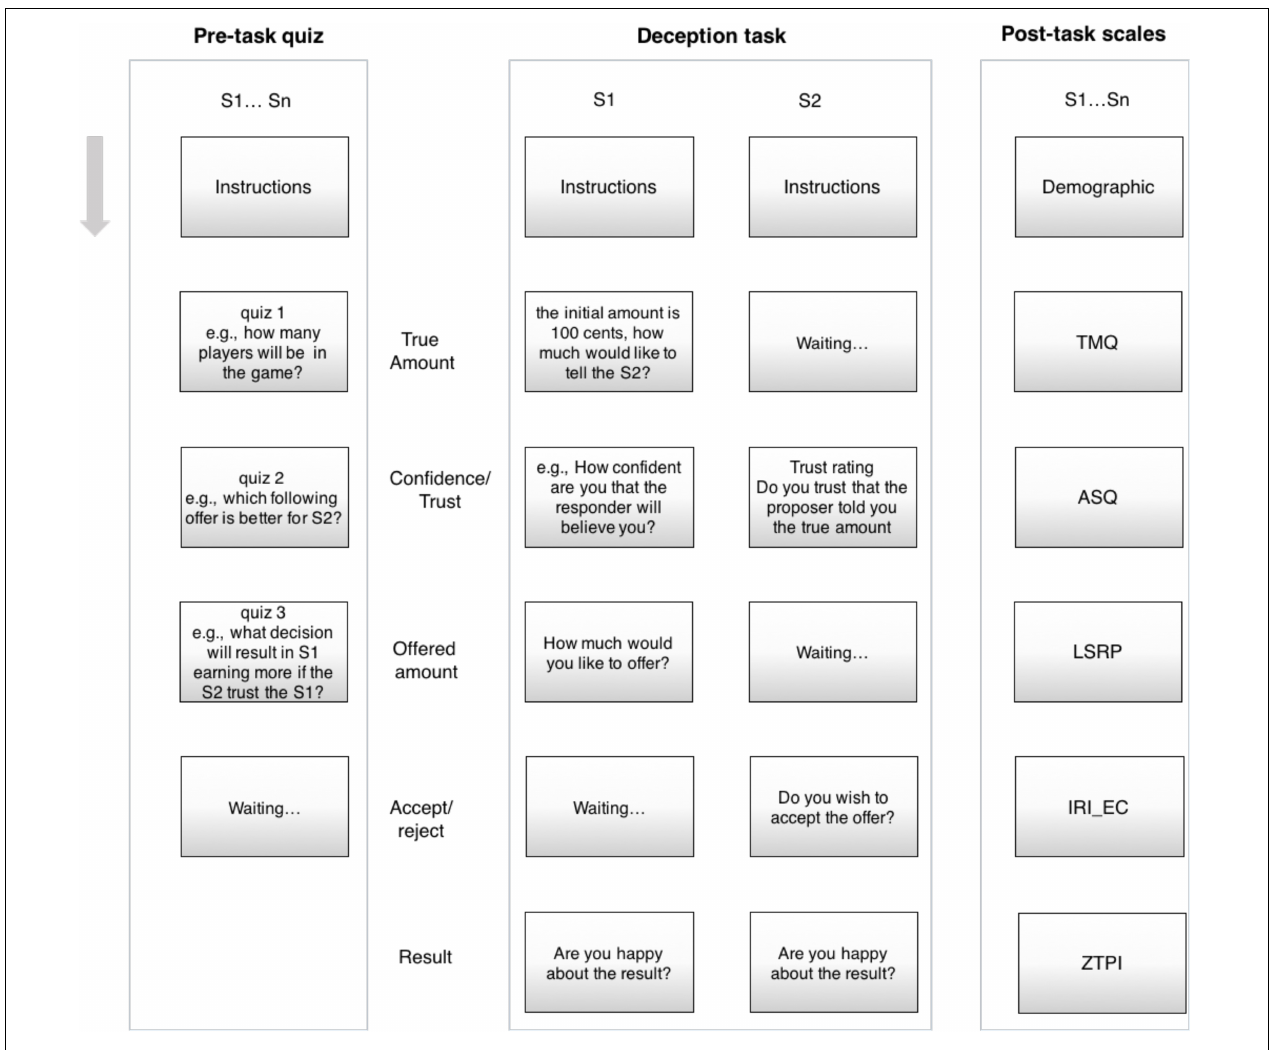
FIGURE 3 | The plot of the MTurk paradigm run in sample